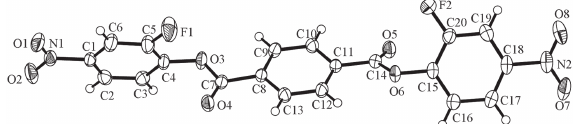
Table 1: Data collection and handling.